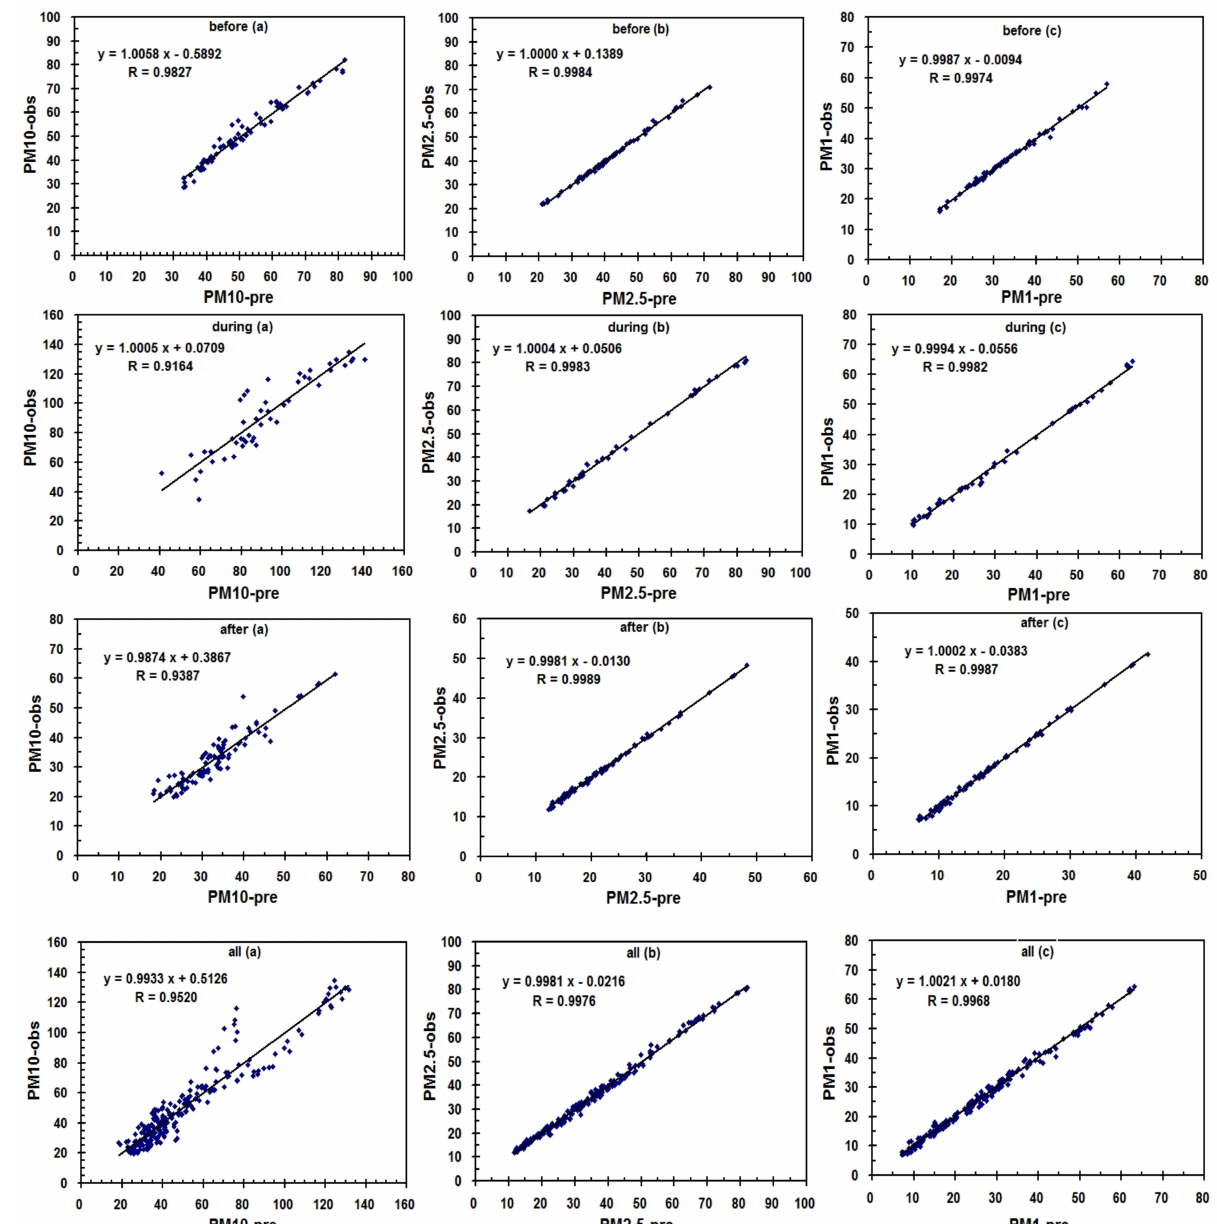
Figure 6. Comparison of observed with calculated PM 10 , PM 2.5 and PM 1 values in ( a – c ) figures before, during and after the dust periods and all periods from 18 March to 21, 2015 at Gangneung city,